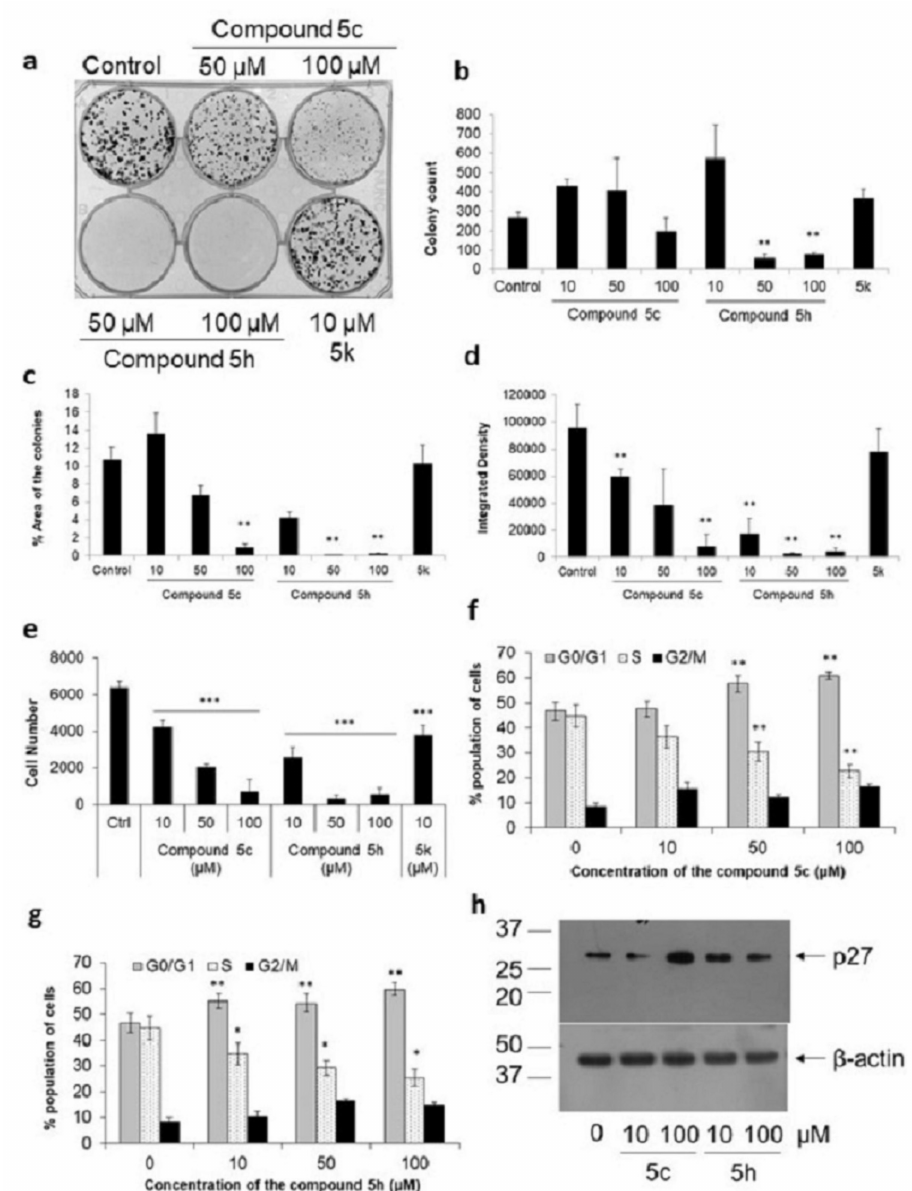
Figure 3. Substituted imidazo[1,2- b ]pyridazine compounds affect IMR-32 cell proliferation. Five hundred cells/well were plated in a 6-well plate and after 48 h stimulated with various compounds. Five days post-stimulation, the colonies were fixed and stained with 0.2% crystal violet. ( a ) A representative image of a plate is depicted here. Using Image J, the total number of colonies ( b ), area covered by the colony ( c ), and integrated density of the colonies ( d ) were calculated as described in Methods. ( e ) IMR-32 cells were plated in a 96-well plate (eight wells per condition) and stimulated with different compounds. After 24 h, CyQUANT NF dye was added and fluorescence measured. ( f , g ) IMR-32 cells were stimulated with different concentrations of the compound 5c ( f ) or 5h ( g ) for 24 h. Cells were fixed and stained with PI, and at least 30,000 cells were counted and analyzed on a flow cytometer. Percentage of total cells in each of the G 0 /G 1 , S, and G 2 /M phases are depicted here. ( h ) IMR-32 cells were stimulated with the compounds for 24 h. Cell lysate was collected for the analysis of p27 Kip1 protein through Western blot. β -actin was used for normalization as described in Materials and Methods. * p < 0.05, ** p < 0.01, and *** p < 0.001, with respect to control cells. Error bars represent SEM, n = 3 independent